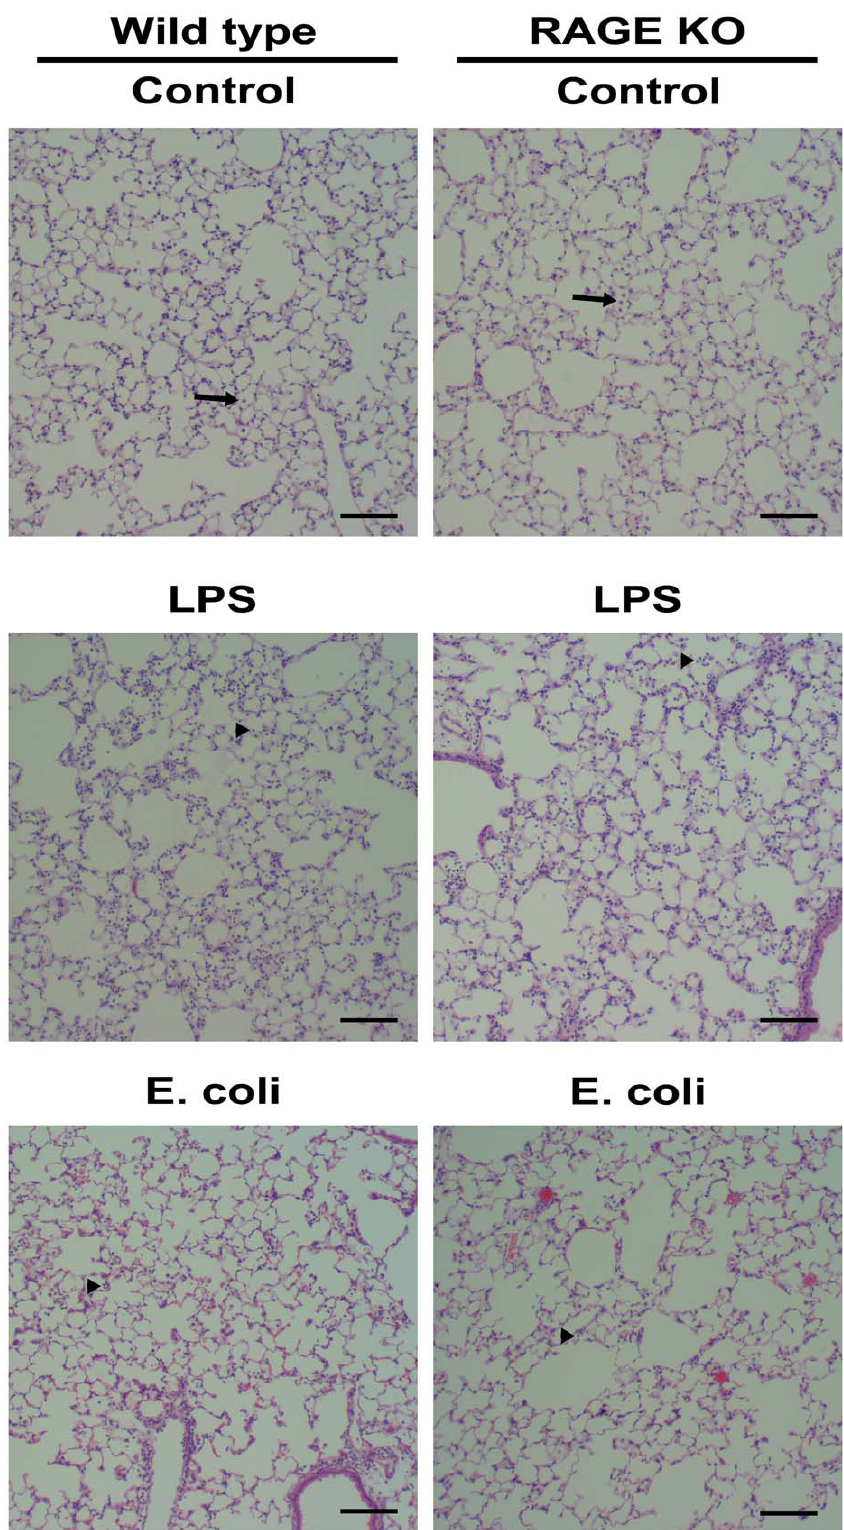
Figure 3. H&E stained lung sections from wild type and RAGE KO control, LPS and E.coli treated mice. The first column shows wild type and the second column shows RAGE KO lungs. Macrophages (arrows) and neutrophils (arrowheads) in alveoli are indicated. First row is control treated from both strains. A few macrophages are present in the alveoli of both control treated strains. LPS treatment, second row, led to a significant infiltration of neutrophils into the alveolar space; however no immediate difference in degree of infiltration was noticeable between the strains. The third row shows lung histology from E. coli treated mice. E. coli treated RAGE KO mice have fewer neutrophils compared to E. coli treated wild type mice. Black bars represent 30 m m.